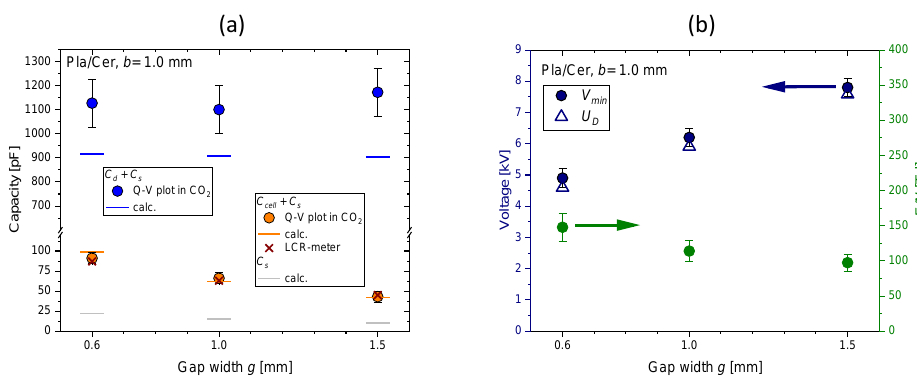
Figure 8. ( a ) Dielectric, cell, and parasitic capacitances. The spacers ( n = 2) are made of mica, which reduces C s . ( b ) Minimum sustaining voltage, discharge voltage, and mean reduced electric field strength for DBD reactors with different discharge gap width g measured in pure CO 2 .